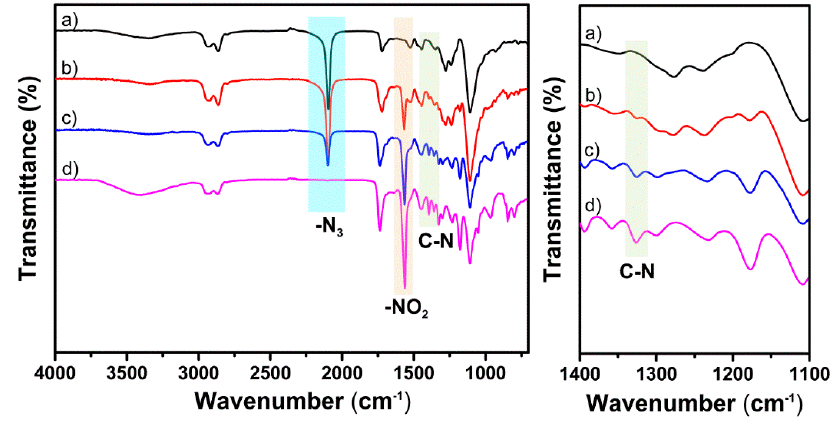
Figure 6. FT-IR spectra of the PDNP/PGT-based PUs in terms of [C ≡ C]/[N 3 ] (mol/mol): ( a ) 0/0.5, ( b ) 0.1/0.5, ( c ) 0.3/0.5 and ( d ) 0.5/0.5.